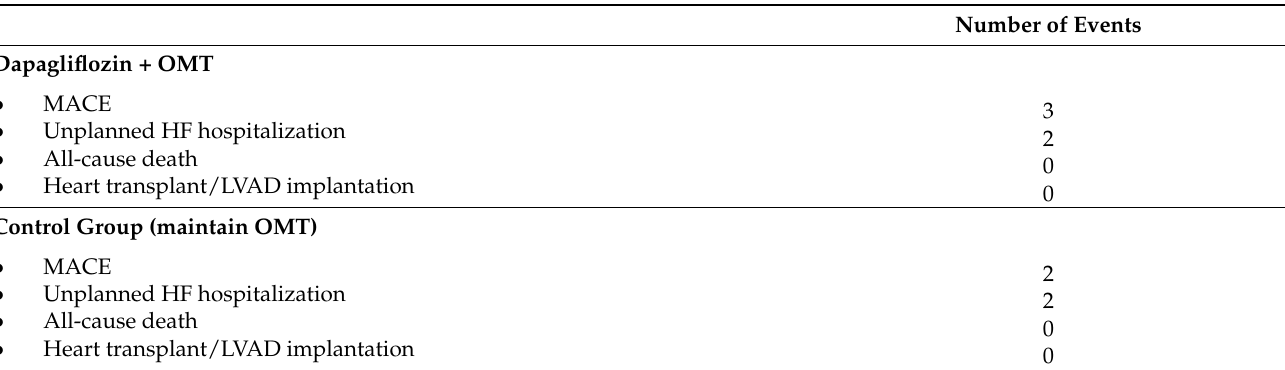
Table 2. Adverse events during 6 months